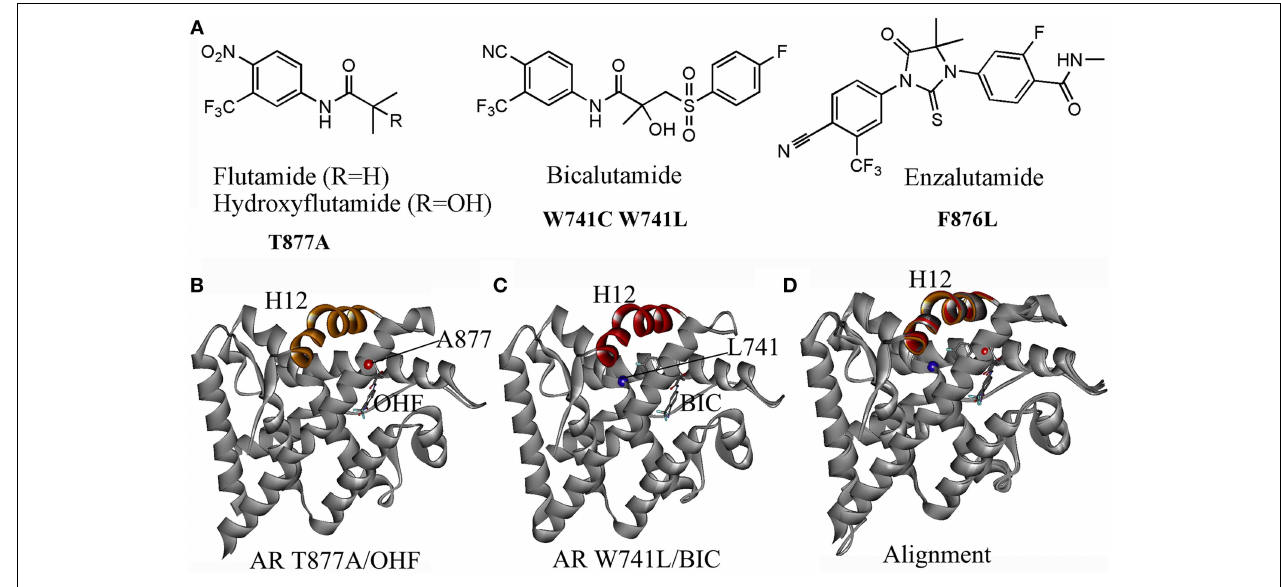
structure (PDB-ID: 1z95) of W741L LBD/ bicalutamide (BIC) shows adopting a agonistic conformation; (D) A superimposition of T877A LBD/OHF and W741L LBD/ BIC structures with the LBD structure bound with DHT (PDB-ID: 1i37) by sequence conferred a perfect alignment of the H12 with the RMSD value of 0.28 and 0.48 Å, respectively, which confirmed the mutant-driven conversion from antiandrogen to AR agonist.